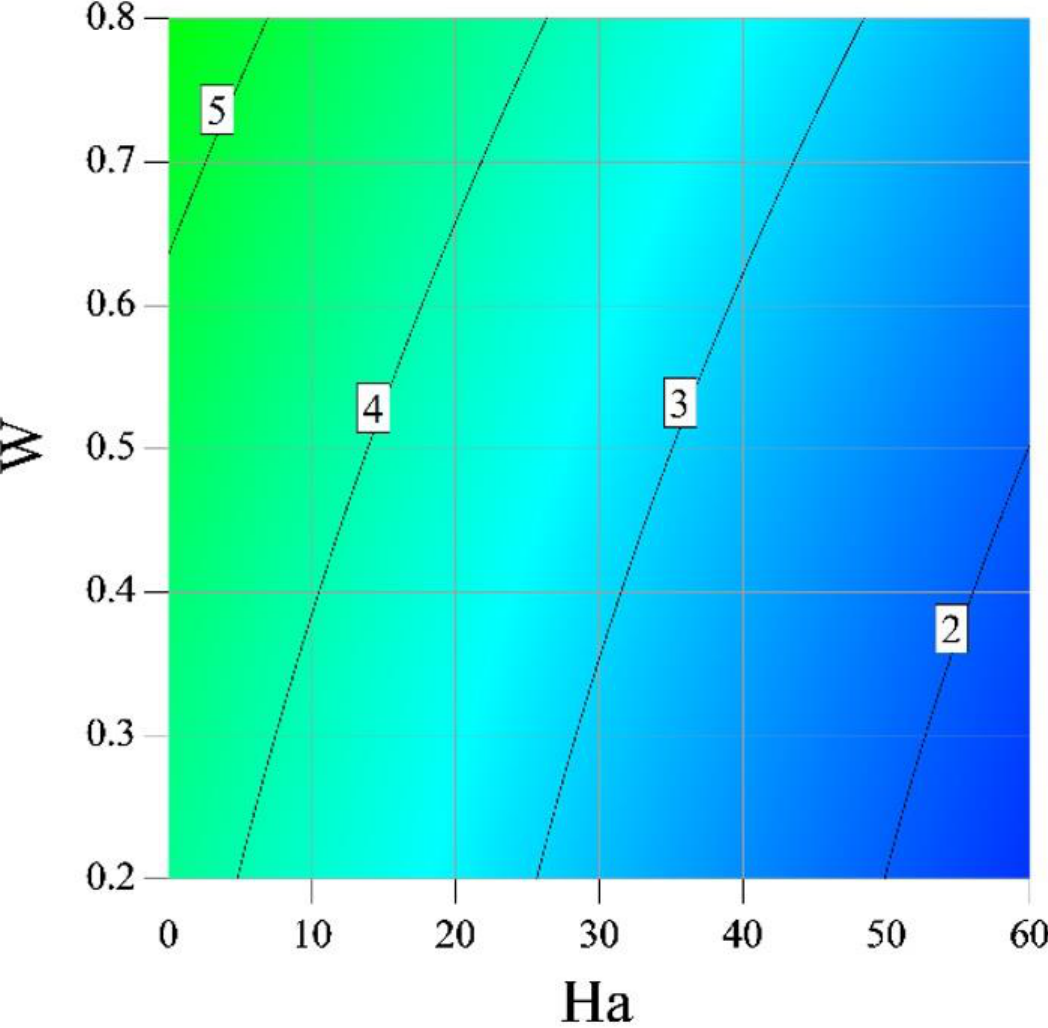
Figure 9. EGN for different Ha and various blade heights when Ra = 10 5 , H = 0.7, and the volume fraction is 0.3%.